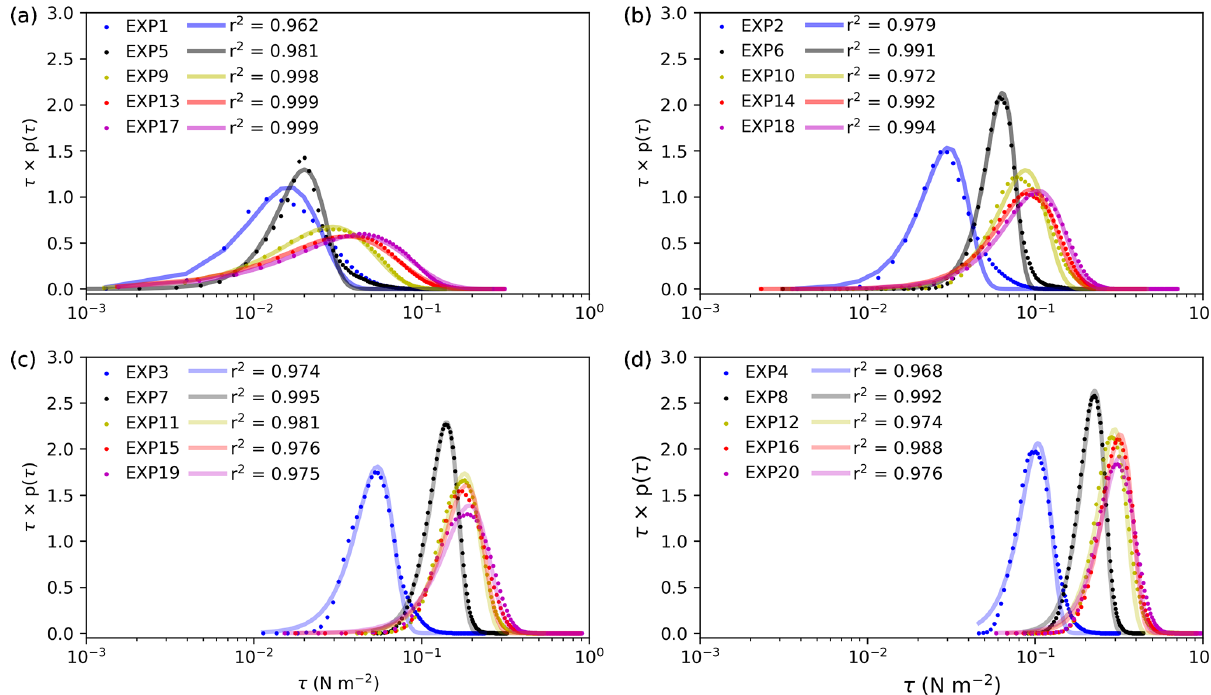
Figure 3. Probability density functions derived from WRF-LES/D simulated surface shear stress τ (dots) and the corresponding fitted Weibull density functions (solid lines, r 2 is the coefficients of determination) for different surface heat fluxes and different wind speeds: (a) U = 4ms − 1 , (b) U = 8ms − 1 , (c) U = 12ms − 1 , and (d) U = 16ms − 1 with z 0 = 0 .